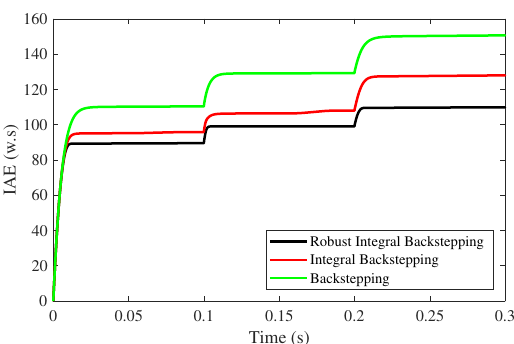
Figure 24. IAE for multiple uncertainties under varying irradiance and temperature.